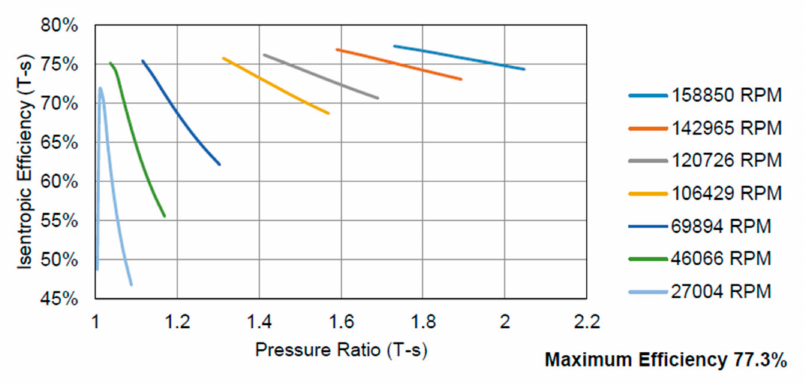
Figure 26. Total to static e ffi ciency vs. pressure ratio plots at constant shaft speeds for axial turbine.